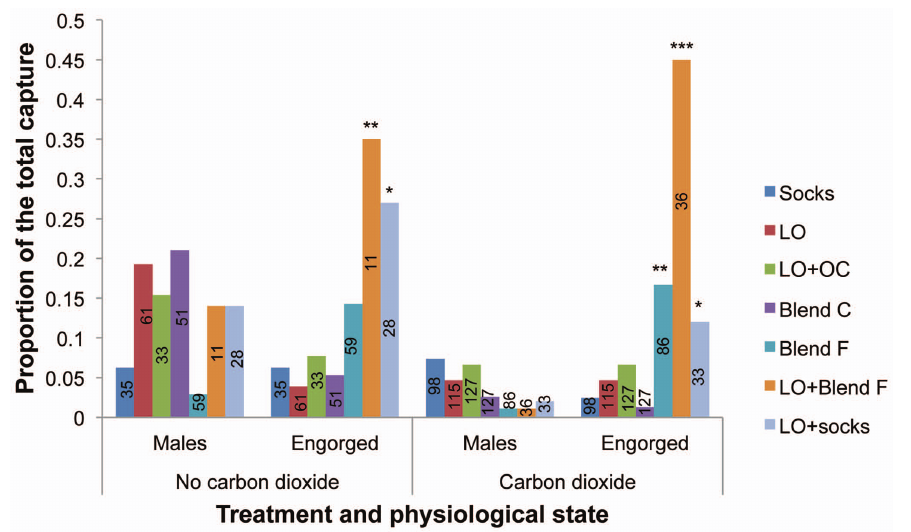
Figure 3. Proportions of male and engorged female An.funestuss.l. caught by different odor treatments. The bars show the proportions of male and engorged (blood-fed + semi-gravid/gravid) female An. funestus s.l. ; numbers embedded in the bars are the total of mosquitoes caught by each of the odor treatment; LO = ( E )-linalool oxide; OC = - b -ocimene; the different treatments were compared to socks (control); bars capped with asterisks are significantly different from their respective controls as determined by chi square test of proportions using R 2.15.1 software * = P , 0.05, ** = P , 0.01, *** = P , 0.001.